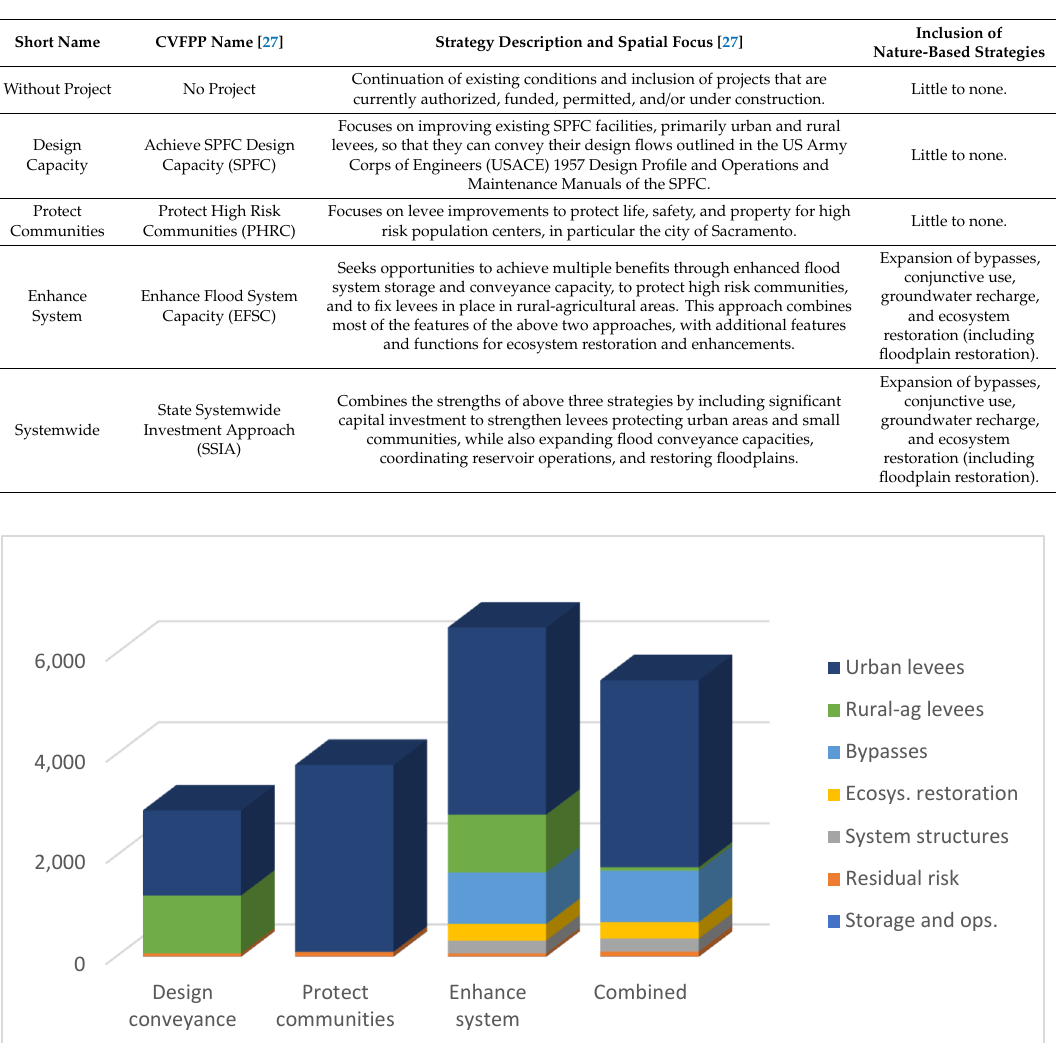
Table 1. Overview of Central Valley Flood Protection Plan (CVFPP) management strategies.